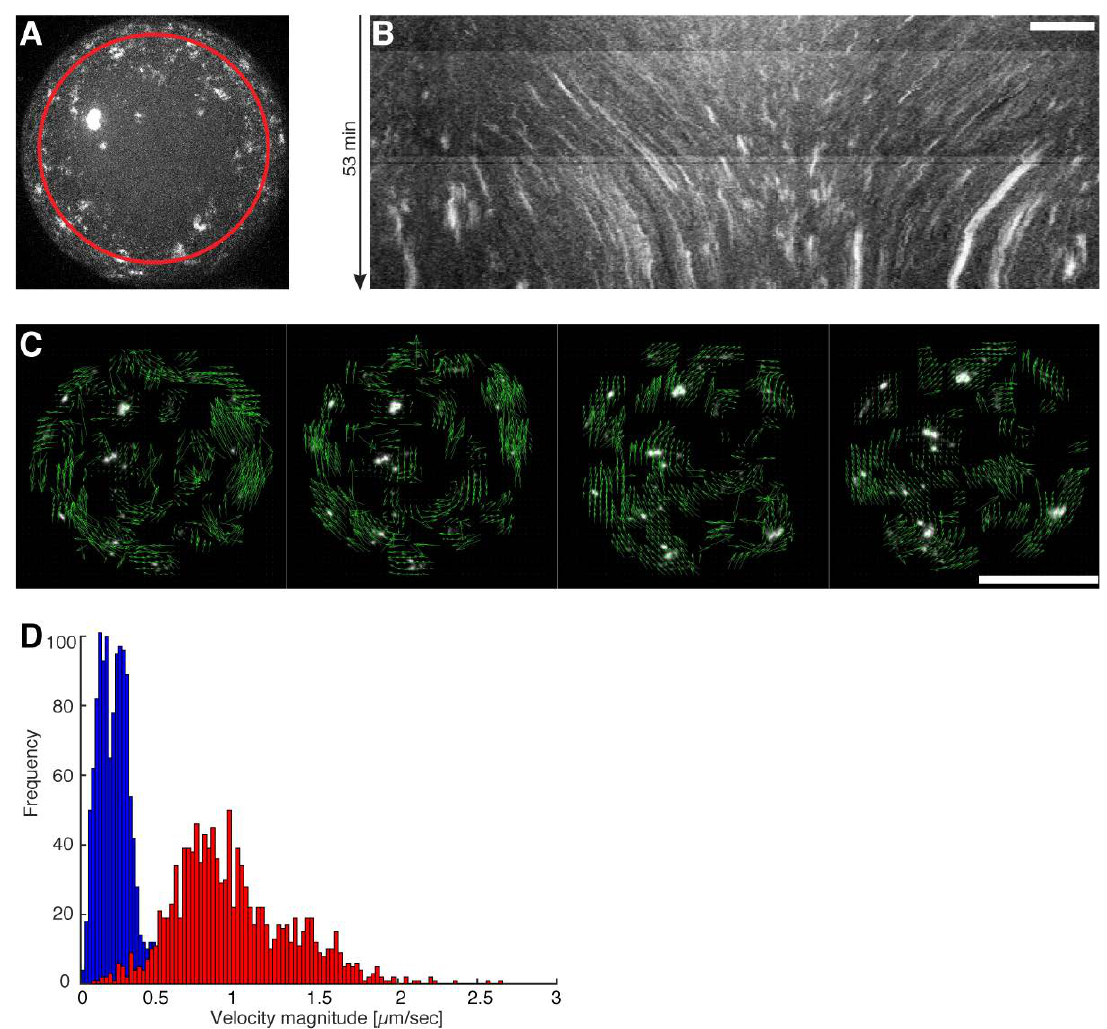
Figure 2. Directed movement of actomyosin clusters upon ATP dependent actomyosin contractions. ( A ) Maximum intensity projection from a half droplet confocal z-stack where Alexa-488 labeled actin clusters are visible (Movie S3). The red circle indicates the path of the generated kymograph. ( B ) A kymograph of the maximum intensity projected half sphere is shown where directed movements of individual clusters represented by distinct lines are visible. Scale bar, 10 µm. ( C ) Confocal time-lapse image sequence used for particle image velocimetry (PIV) by ( 21 ). Vectors (green arrows) indicate the flow direction of the directed movement of the actomyosin clusters (Movie S4). Scale bar, 50 µm. ( D ) Velocity profiles measured by PIV of droplets with (red) and without a crowding agent (blue) are shown (Movies S3 and S5).